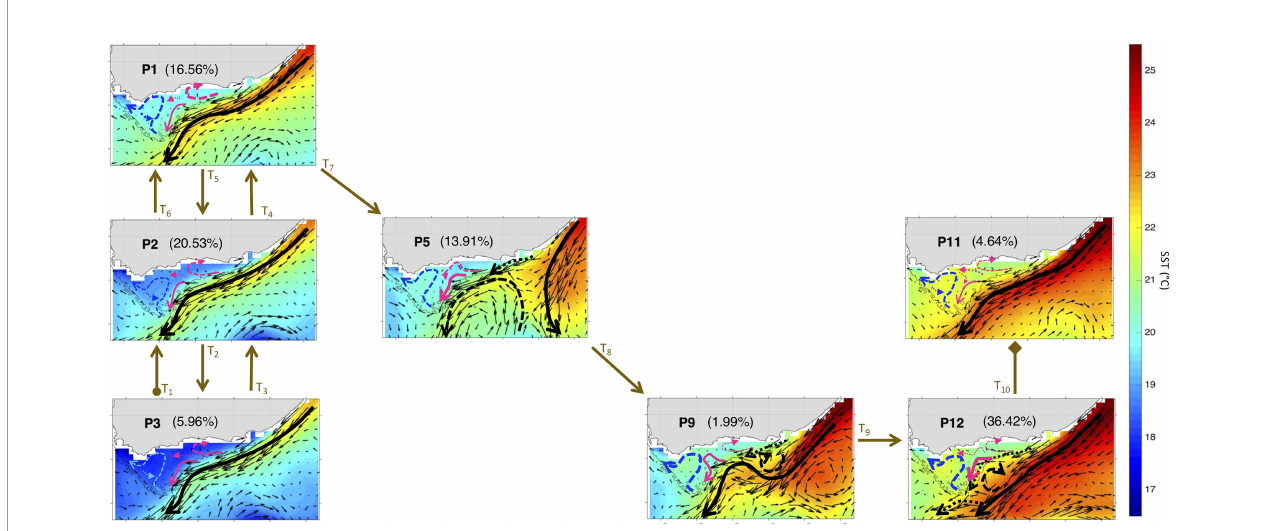
FIGURE 12 | Same as Figure 3 but for Nov-Mar 2010-11. The frequency of occurrence of each pattern is calculated here relative to the days recorded during Nov-Mar 2010-11. The brown arrows represent the SOM patterns trajectories (T i=1:10 ) evolving during Nov-Mar 2010-11 as inferred from the BMU timeseries ( Supplementary Figure 4A ). The starting ( fi nal) trajectory is designated with a circle (diamond) at the arrow beginning (end).